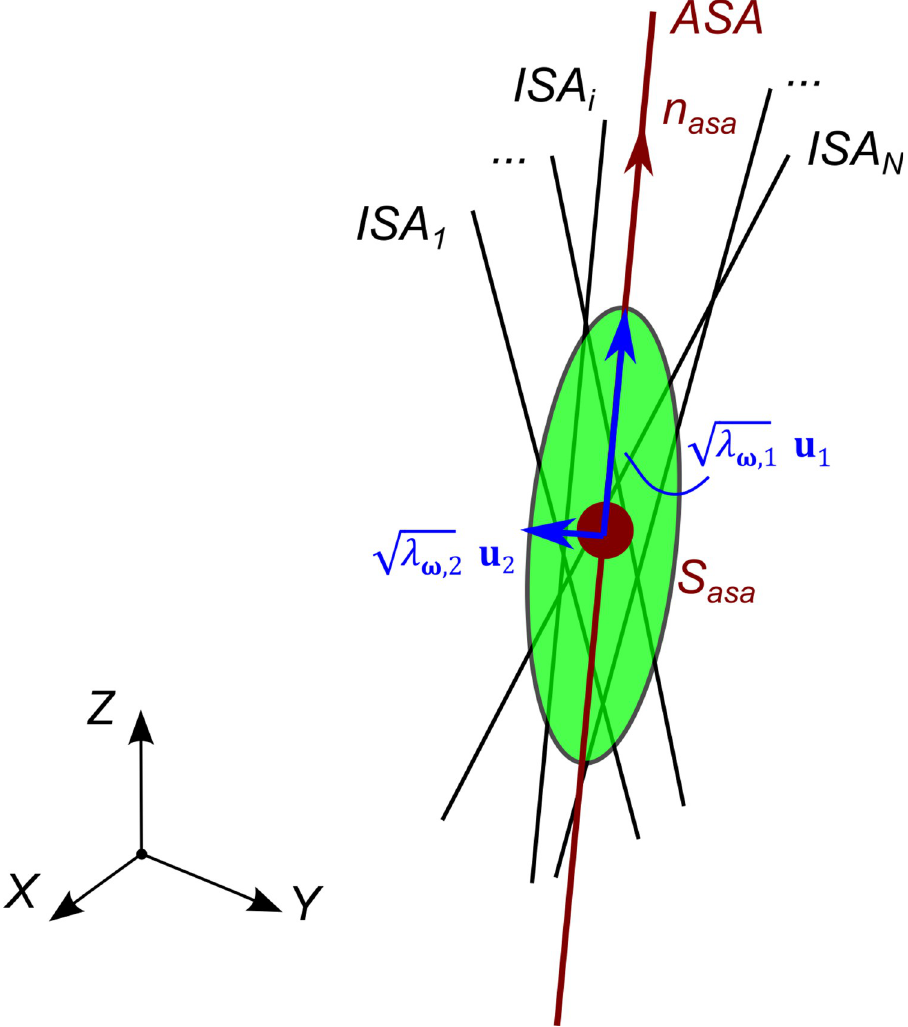
Fig 3. Analysis of the dispersion of the ISAs with respect to the ASA, represented as the confidence ellipsoid.